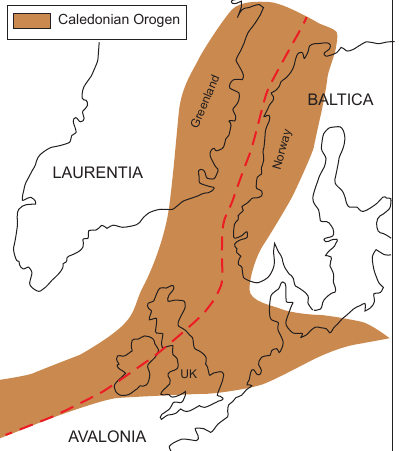
Figure 2. The main zone of continent-continent collision at the end of the Caledonian Orogeny. The red stippled line shows the inferred trace of the Iapetus